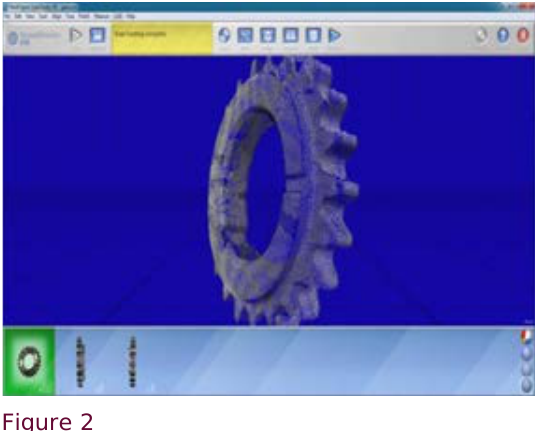
Figure 2 A mesh view of a gear in ScanStudio HD.